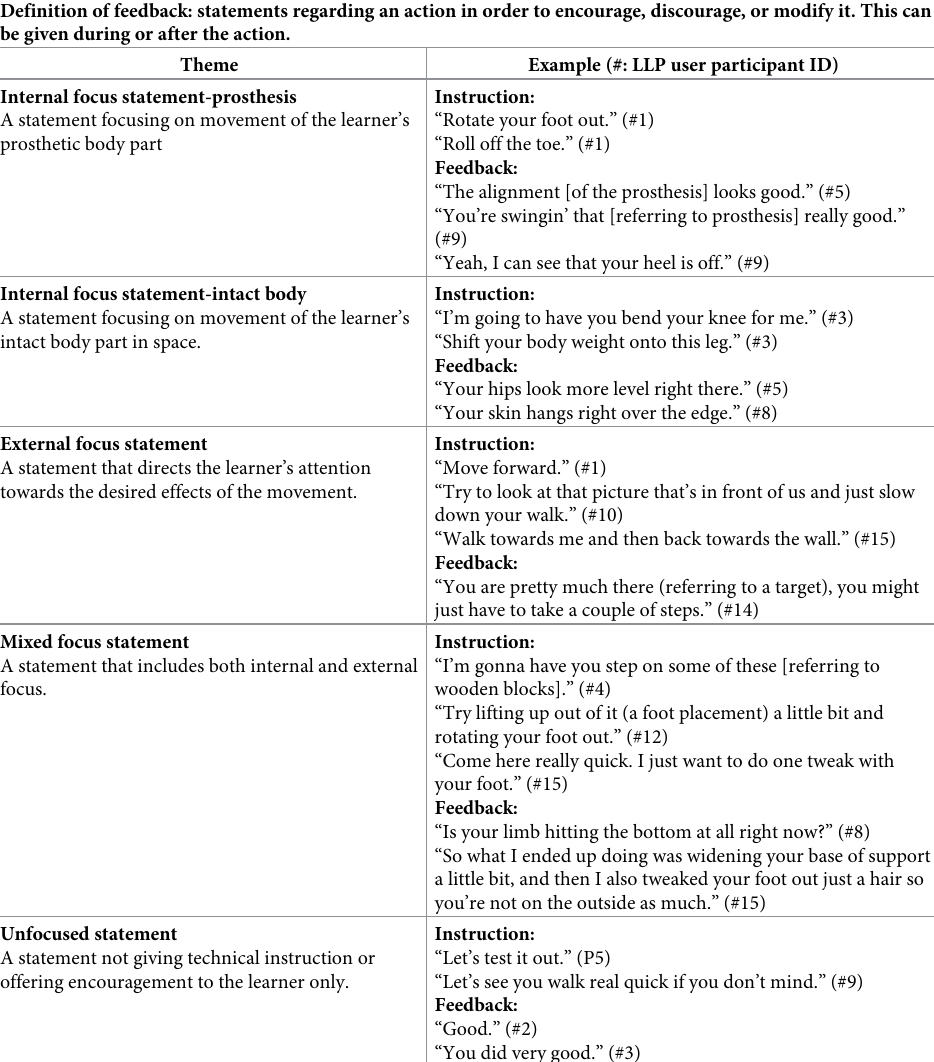
Table 1. Definitions and examples of the attentional focus themes. Definition of an instruction: statements regarding how an action is to be performed Definition of feedback: statements regarding an action in order to encourage, discourage, or modify it. This can be given during or after the